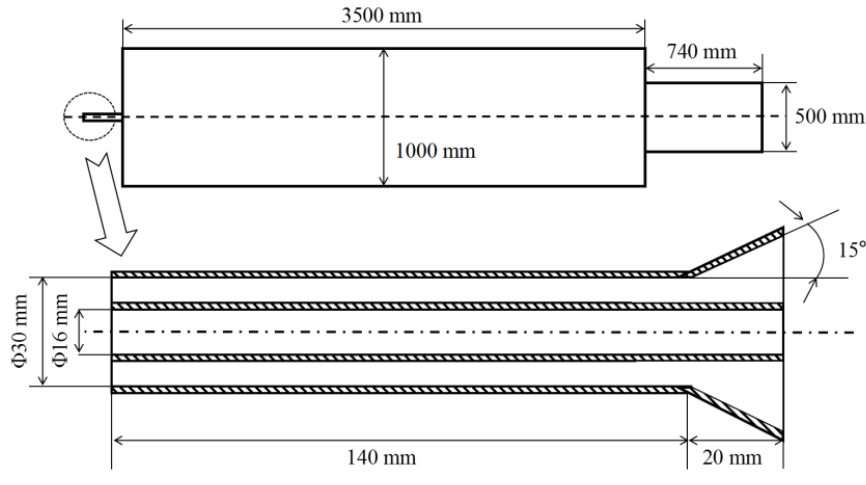
Figure 1. Diagram profile of simplified model of casing swirl burner.